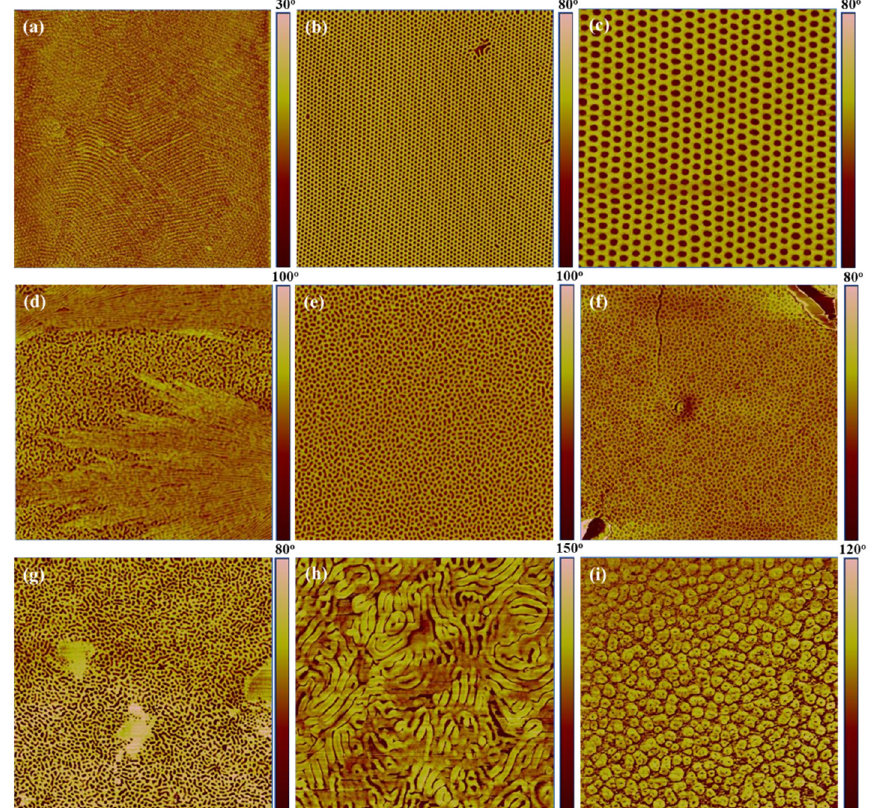
Figure 4. AFM phase images (in all images, the scale is 3 μ m × 3 μ m except for Figure 4c, where the scale is 1 μ m × 1 μ m) corresponding to: ( a ) the pristine initial diblock copolymer (SI) where hexagonally close-packed cylinders parallel to the substrate surface are observed (toluene/R.T.); ( b – g ) the 100% hydrogenated (SEP) material where ( b , c ) well-ordered hexagonally close-packed cylinders are evident (toluene/R.T.); ( d ) sponge-like structures in combination with crystallites are obvious (cyclohexane/80 ◦ C); ( e ) hexagonally close-packed cylindrical topology is obtained (THF/80 ◦ C); ( f , g ) disordered structures are observed (THF/100 ◦ C and 120 ◦ C, respectively); ( h , i ) the partially sulfonated (SI/sulf) copolymer where ( h ) horizontal cylinders (cyclohexane/R.T.) and ( i ) a micellar structure (cyclohexane/80 ◦ C) are